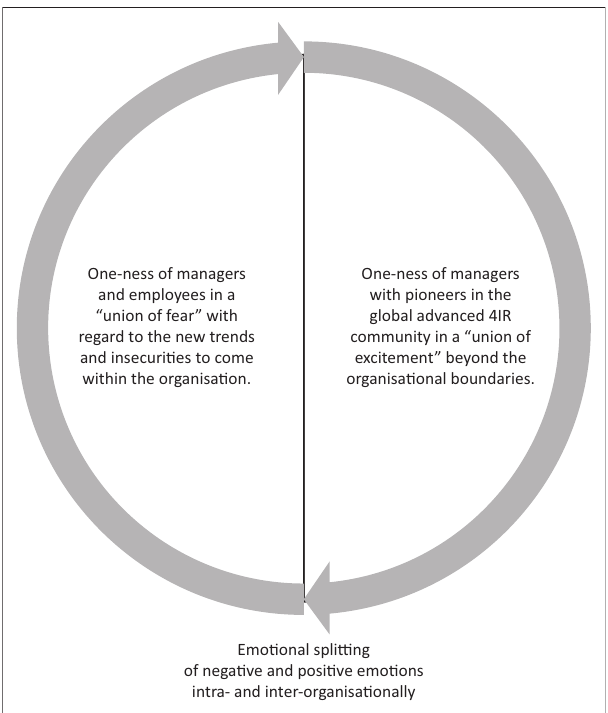
FIGURE 4: One-ness.